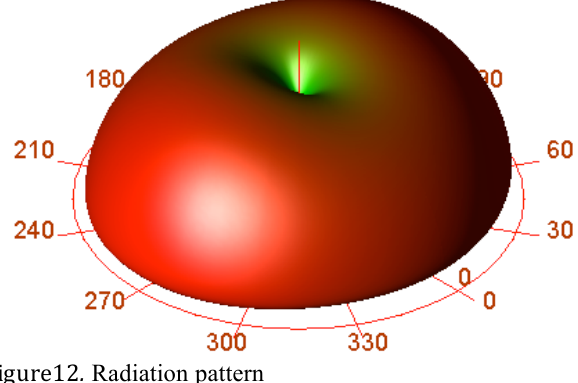
Figure12 . Radiation